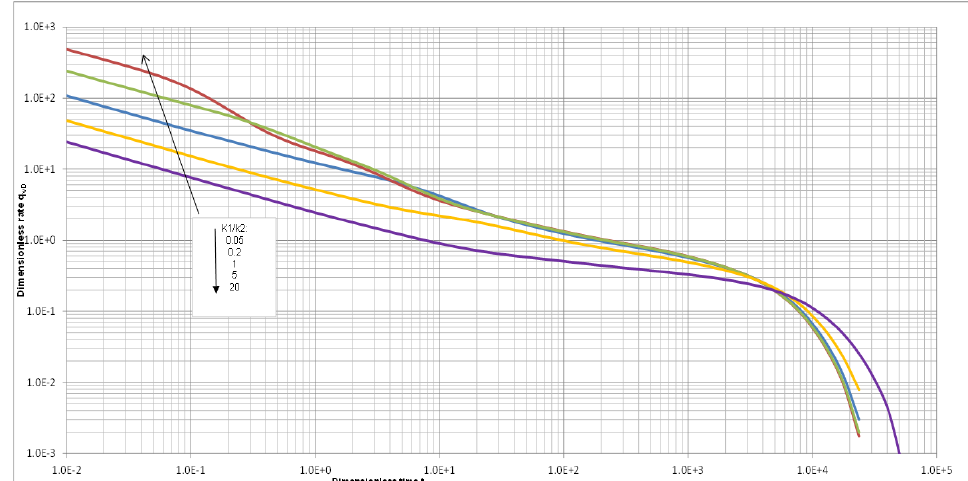
Figure 20. Rate behaviors of a fractured, horizontal well under a different permeability ratio k 1 / k 2 , with 2 L fD / Y eD = 0.1, w srvD / d fsD = 0.5, X eD = 200, and Y eD = 100.